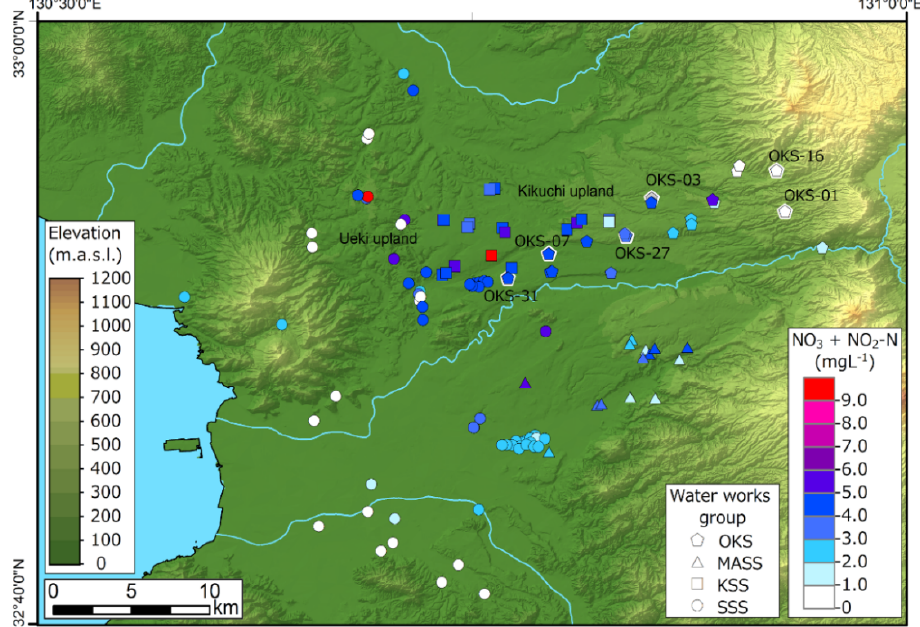
Figure 4. Pre-seismic groundwater nitrate concentrations.